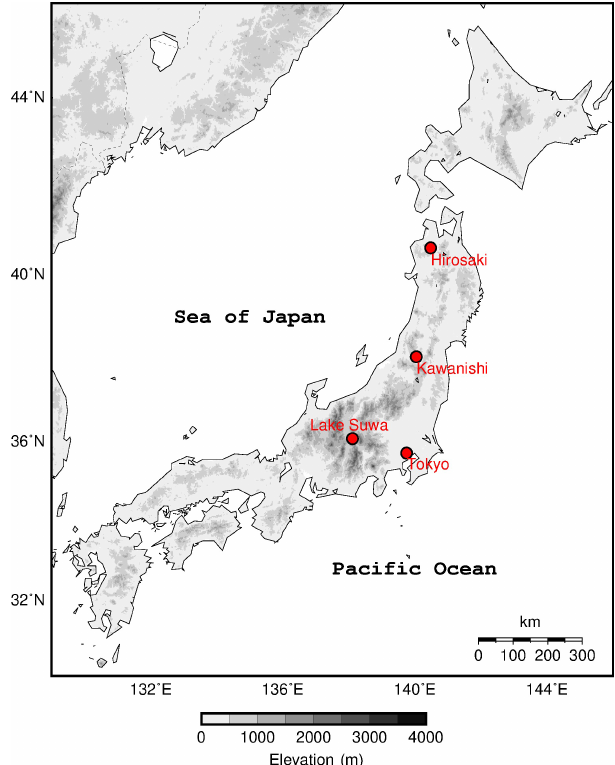
Figure 1. Locations of the historical daily weather records, Lake Suwa, and the instrumental temperature data used in this